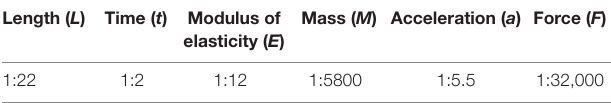
TaBle 1 | scale factors of the model structure.